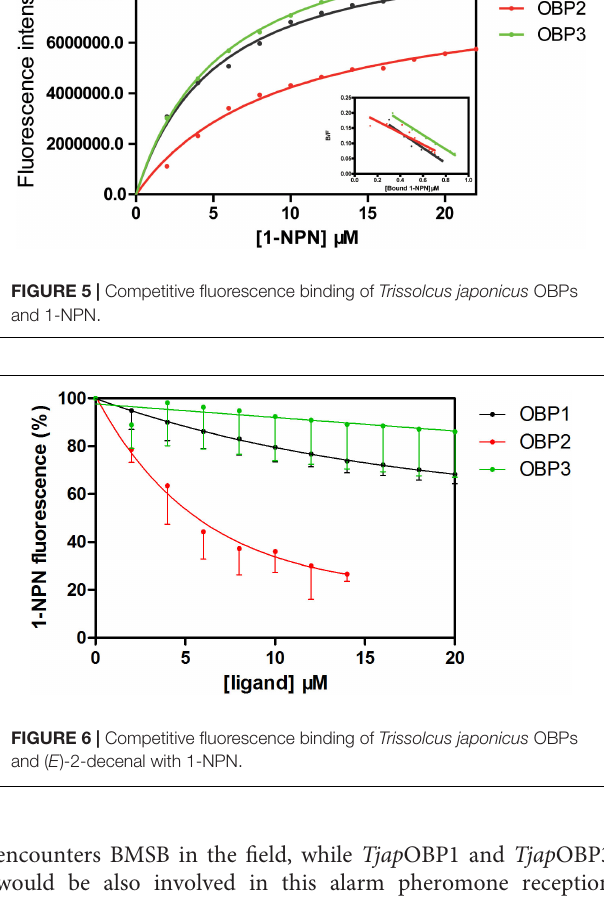
TABLE S1 | Overview of RNA-sequencing data of Trissolcus japonicus . TABLE S2 | Assembly of unigene and transcripts of Trissolcus japonicus . TABLE S3 | Annotation of Trissolcus japonicus unigenes with BLAST. TABLE S4 | The FPKM values of OBPs in different tissues of Trissolcus japonicus . FIGURE S1 | Gene ontology (GO) classification of T. japonicus transcriptome. Unigenes were classified into three main categories: biological process, cellular component, and molecular function. The Y-axis indicates the percentage of a specific category of genes in each main category. FIGURE S2 | KEGG functional classification of T. japonicus